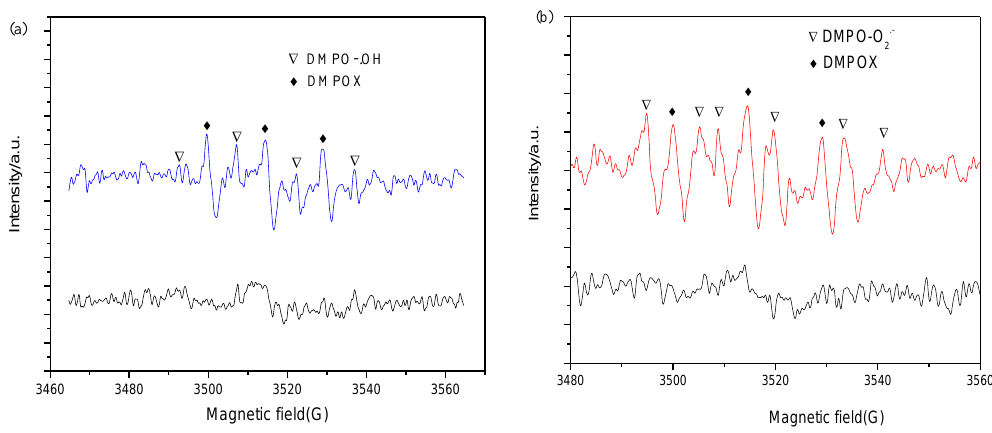
Figure 12. Electron paramagnetic resonance (EPR) spectra of hydroxyl ( a ) and superoxide ( b ) radicals over the BiOI/BiOCl sample under solar light irradiation (DMPOX was denoted as oxidized 5,5-dimethyl-1-pyrroline N-oxide (DMPO)).